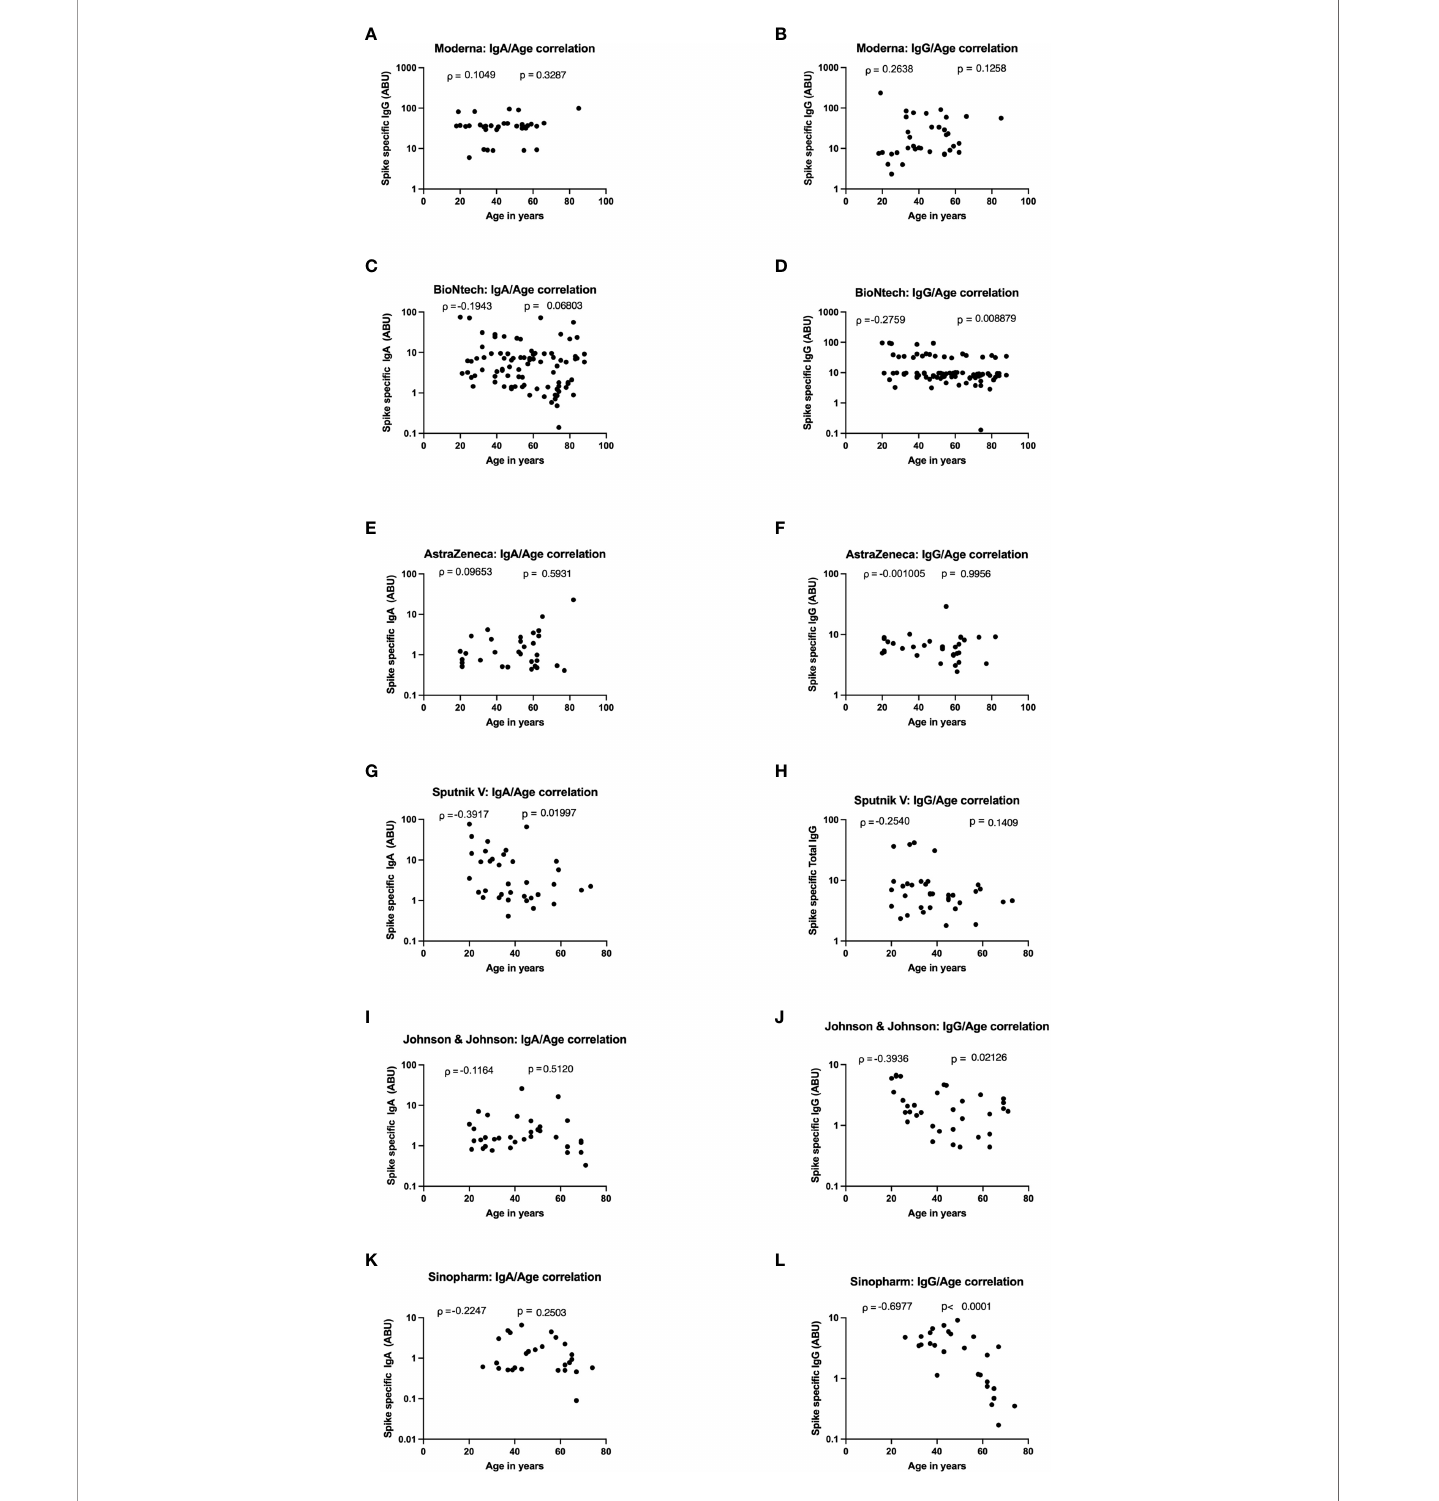
FIGURE 4 | Strong age-dependent decrease of vaccine-induced antibody decrease in Sputnik-V, Johnson and Johnson, and Sinopharm vaccinees. Graphs represent the correlation of SARS-CoV-2 speci fi c spike-protein binding IgG and IgA with age in Moderna ( A , B ), BioNTech ( C , D ), AstraZeneca ( E , F ), Sputnik-V ( G , H ), Johnson and Johnson ( I , J ), and Sinopharm ( K , L ) vaccinees. Dots represent individual donors. Indicated r values were calculated using Spearman ’ s rank-order